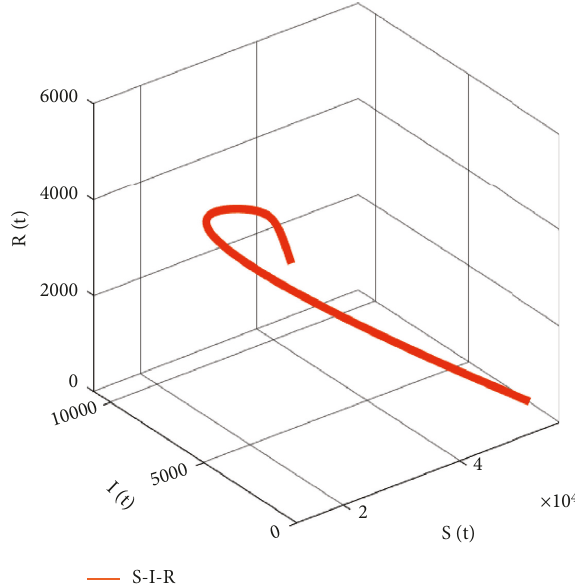
Figure 13: Simulation of human individuals on 3-dimensional